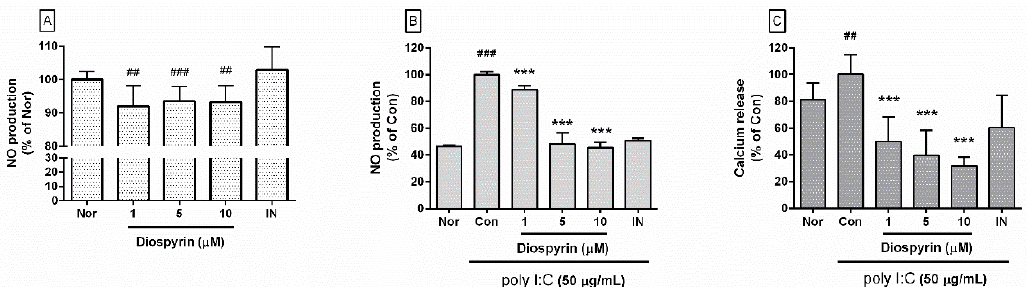
Figure 2. Effect of diospyrin on production of nitric oxide ( A , B ) and calcium release ( C ). Values are mean ± SD of the three independent experiments. Nor, normal group (media only); Con, control group (poly I:C alone); IN, indomethacin (0.5 µ M). ## p < 0.01 vs. Nor; ### p < 0.001 vs. Nor; *** p < 0.001 vs. Con.